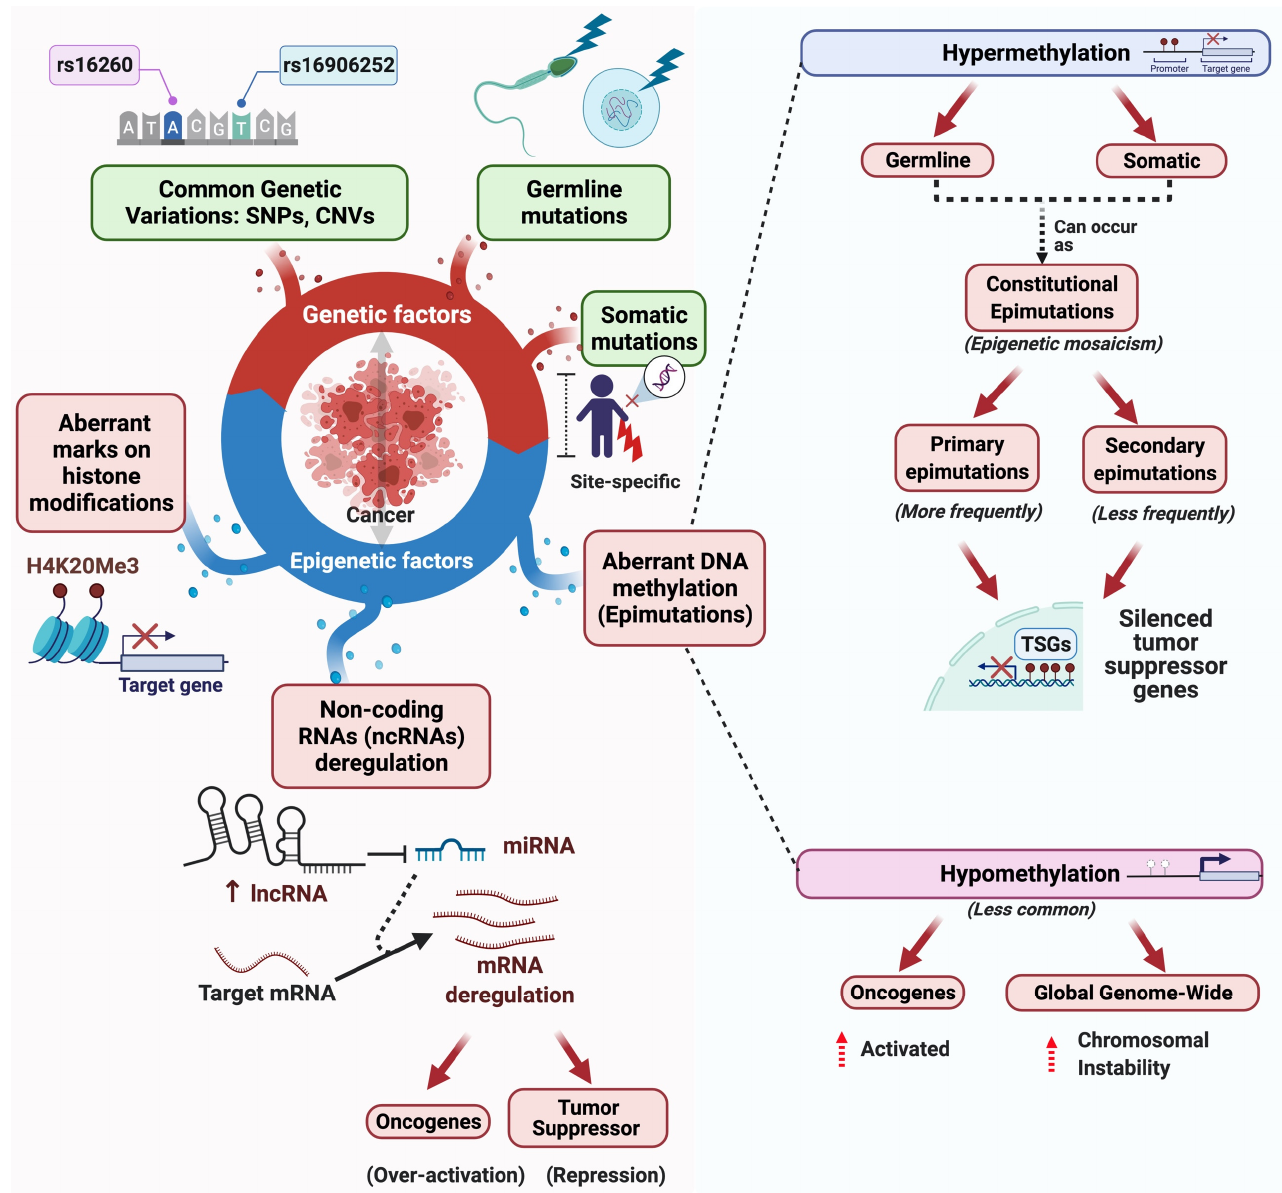
Figure 1. Contribution of genetic and epigenetic factors (epimutations) to cancer development. Cancer is caused by genetic factors such as genetic variations, somatic, and germline mutations and by epigenetic factors such as non-coding RNA dysregulation, post-translational alterations in histone marks, and aberrant DNA methylation (epimutations). DNA hypermethylation is the most frequent epimutation and can be generated either from the germline or somatic cells. In germline epimutations (before fertilization), all cells in the body are affected, while in somatic mutations (after fertilization) epigenetic mosaicism can be generated.